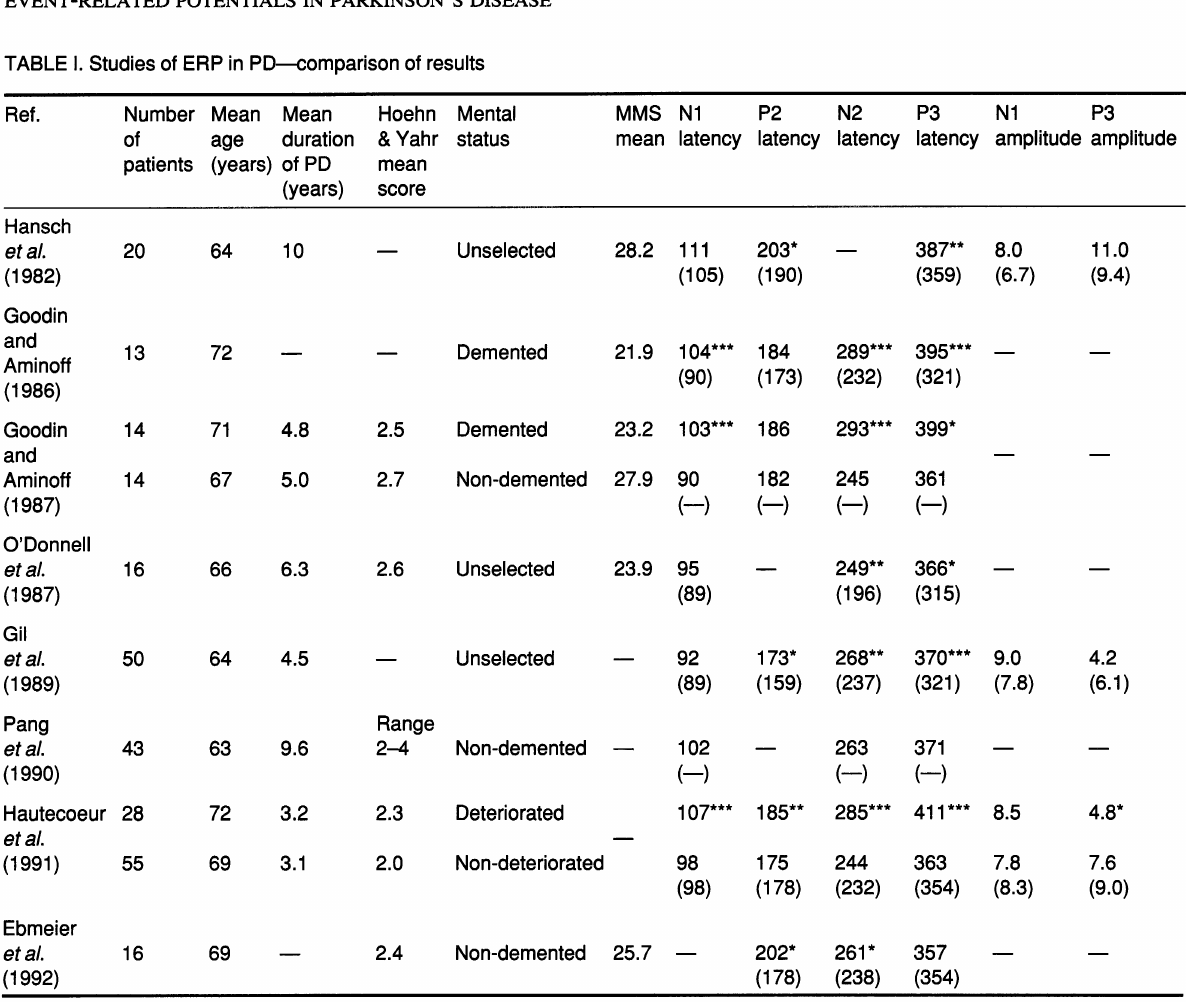
TABLE I. Studies of ERP in PD--comparison of results